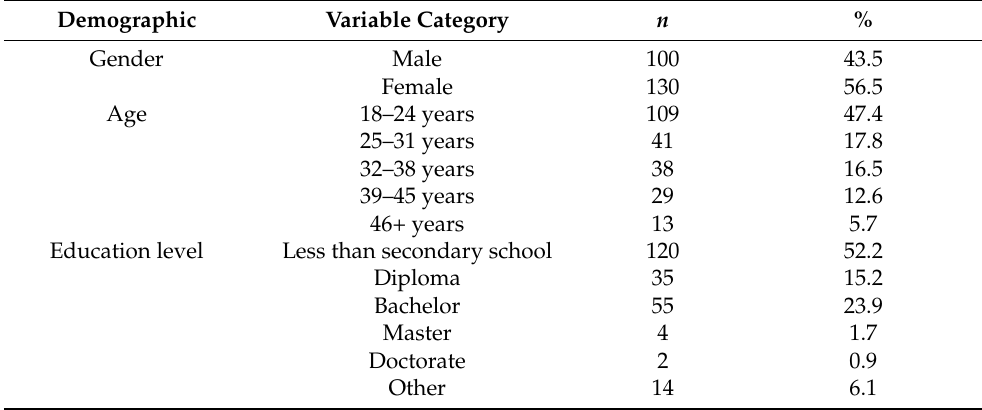
Table 1. Sociodemographic of refugees’